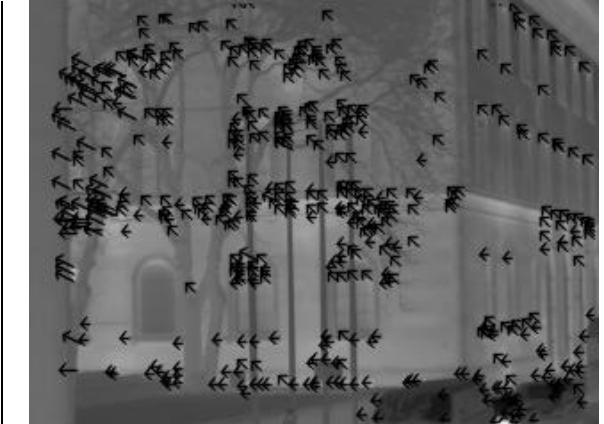
Figure 2. IR image with selected SIFT features, that have correspondences in the following image. Arrows show the moving direction of the points and numer of pixels they move.